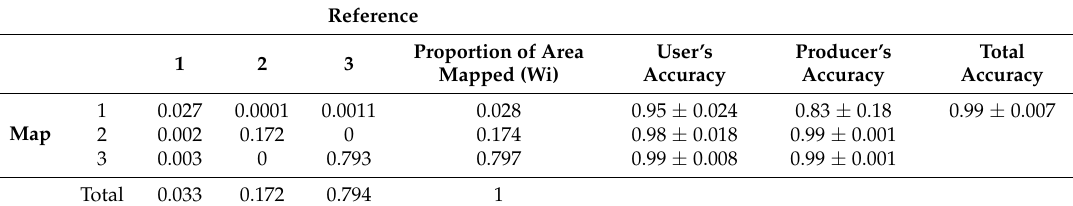
Table 1. Area-weighted error matrix of Landsat-based BFAST Monitor results using stratified sample sites across classes: (1) Disturbance; (2) Non-disturbance outside the 2 km unpaved roads buffer; and (3) Non-disturbance inside the 2 km unpaved roads buffer.